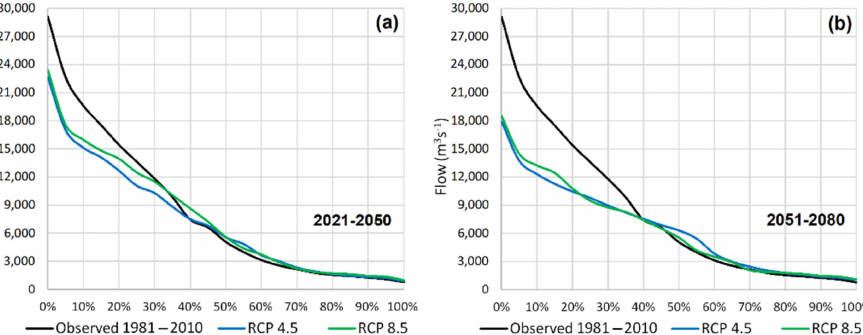
Figure 13. The observed flow permanence curve in the reference period of 1981–2010 (black) in Altamira and the ones projected for the 2021–2050 ( a ) and 2051–2080 ( b ) periods, based on the RCP 4.5 (blue) and the RCP 8.5 (green) scenarios.